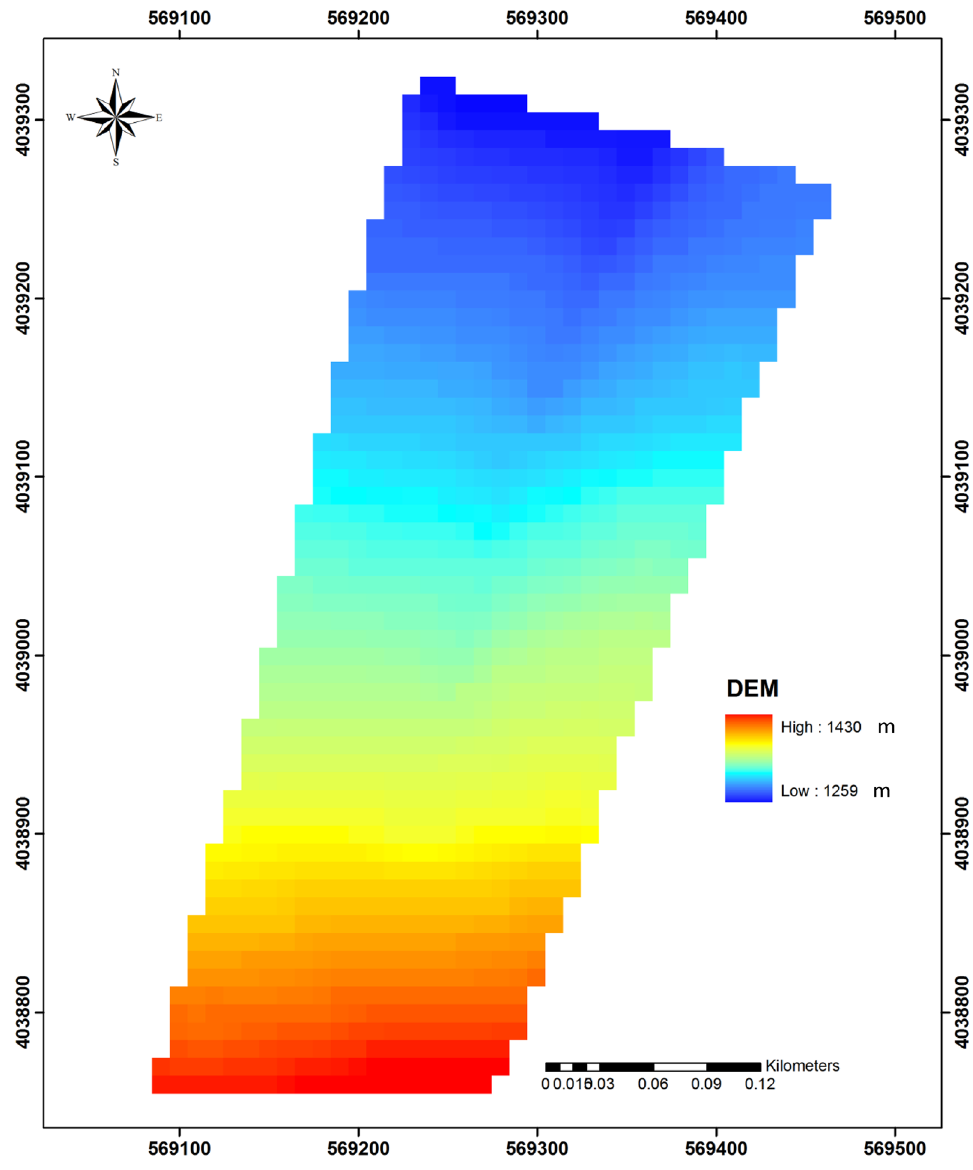
Figure 2. Digital Elevation Model (DEM) map of study